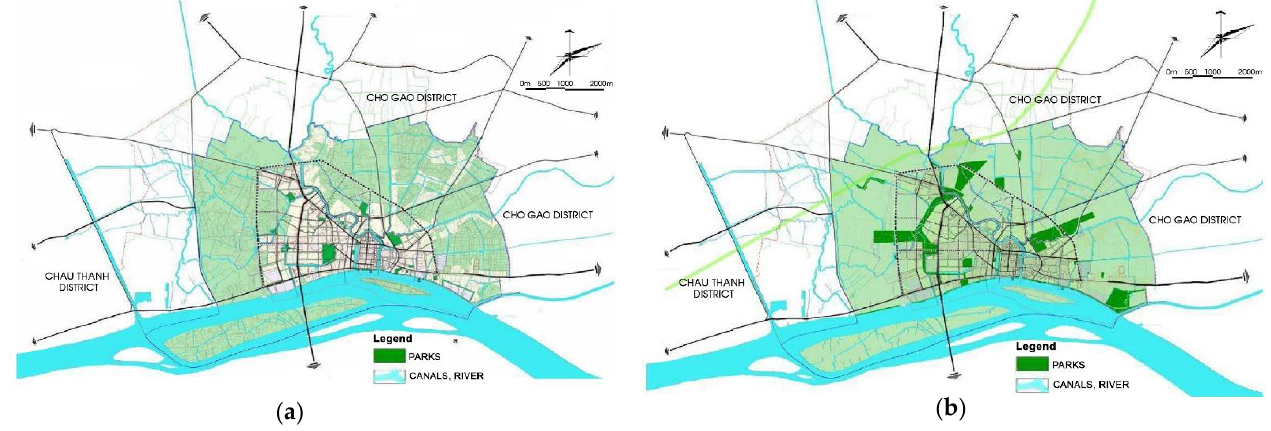
Figure 11. The system of green patches and open spaces is relatively limited in the 2003 Master Plan ( a ); and the addition of green corridors in the form of the EI model ( b ). Source: Adapted from SISP.